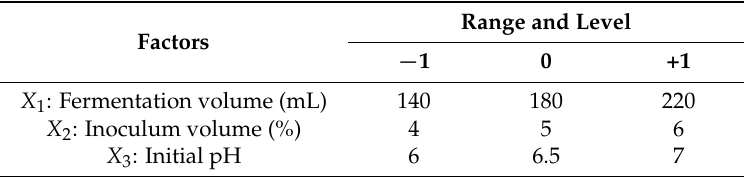
Table 3. Experimental ranges and levels in the experimental design.